Question: Generate an informative caption for the figure above.
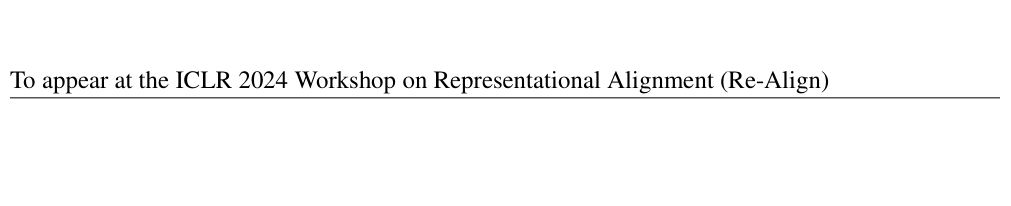
Answer: shows a comparison between biased and debiased CKA across ResNet18 (CORnet-S re- sults reported in Appendix A.6) for a subset of fMRI ROIs, categorized into early (V1, V2, V3), intermediate (hV4, VO1, TO1) and late (lFFA, lPPA, lEBA) groups (Witthoft et al., 2013). For the original data order, the reported value is the mean across the three fMRI participants (N = 3), while for the shuffled order, the reported value is the mean across five random shuffles per participant (N = 3 × 5 = 15). For all ROIs and ResNet18 layers, biased CKA indicates an alignment for the original data order which is only slightly larger than for shuffled data. This indicates that biased CKA is not primarily sensitive to stimuli-driven responses. Debiased CKA does not suffer from this undesirable side-effect and returns a positive value only for stimuli-driven neural responses. It is only via debiased CKA that we recover previously-reported observations that early visual regions are more aligned with lo